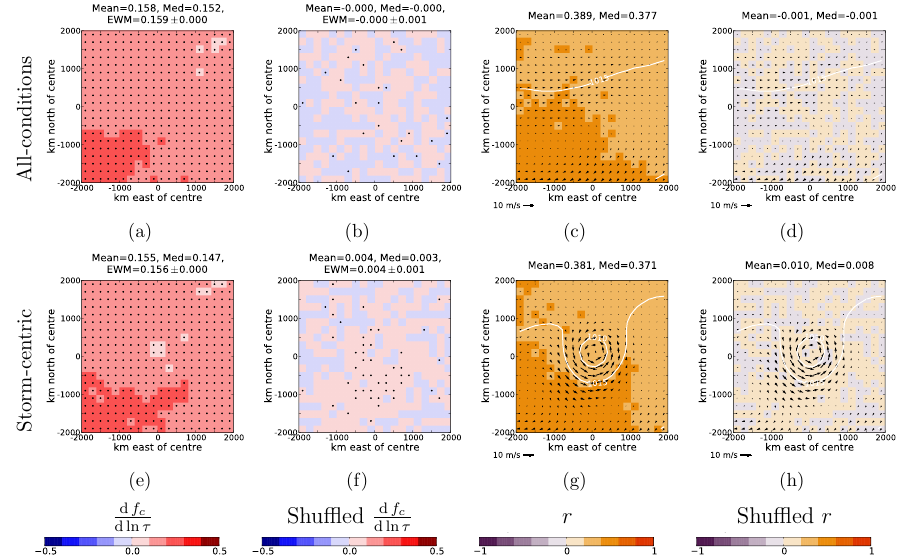
Figure 3: Fig. 3. (a) All-conditions results of an ordinary least squares regression fit of Aqua-MODIS cloud fraction ( f c ) versus ln aerosol optical depth (ln τ ) over the North Atlantic ocean. (b) Similar to (a) , but for f c and ln τ data which have been shuffled within each narrow relative vorticity range. Stippled slopes are statistically significant for a t test two-tailed p value threshold of 0.05. (c) Linear Pearson correlation coefficients ( r ) corresponding to the slopes shown in (a) . Median composites of ERA-Interim mean sea level pressure ( p 0 ; white contours) and wind vectors (black arrows) are over-plotted. (d) Correlation coefficients corresponding to the slopes of the shuffled data shown in (b) . (e–g) Similar to (a–d) , but for storm-centric data rather than all-conditions data.